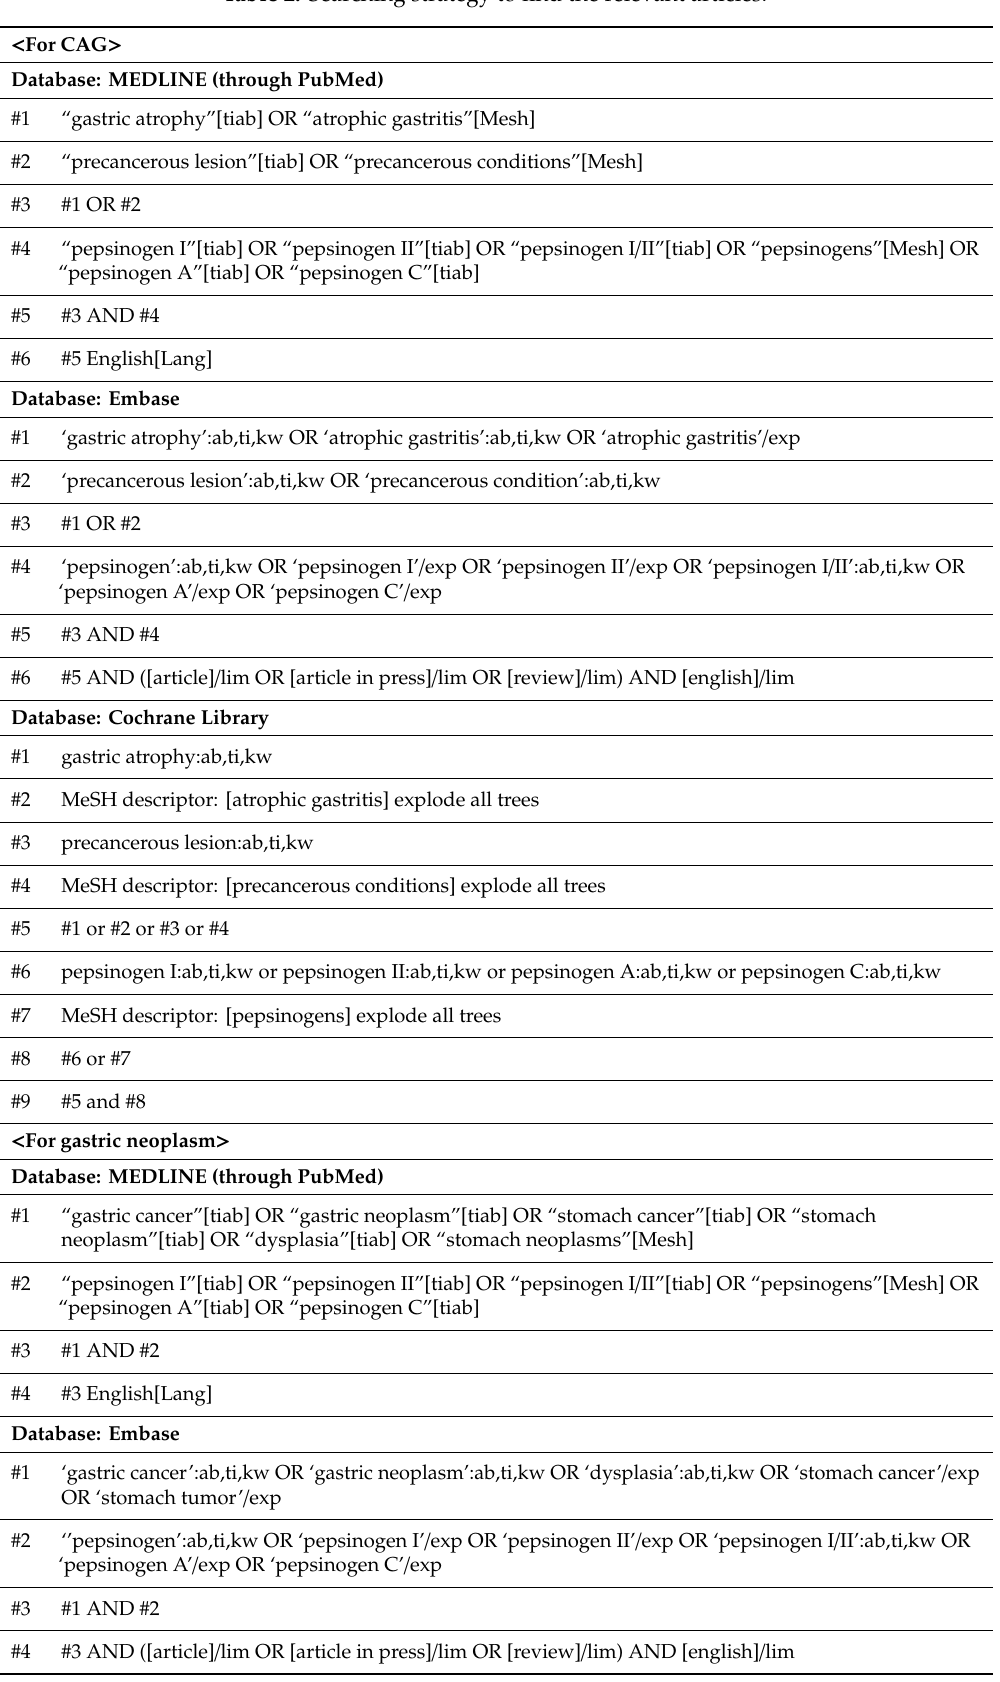
Table 2. Searching strategy to find the relevant